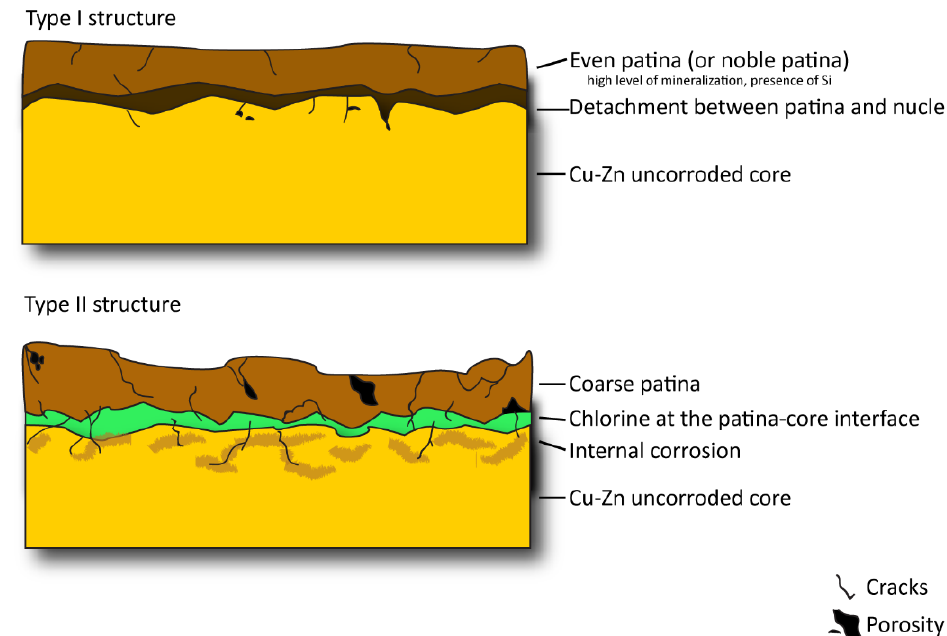
Figure 8. Schematic representation of the Type I ( up ) and Type II ( down ) corrosive structures of orichalcum samples. In the scheme the damages that occurred in both types of structures are evident, highlighting the highest degree of degradation in Type II, due to cracks and induced porosity causing internal corrosion and the settlement of chlorine-rich fluid at the patina–core interface.